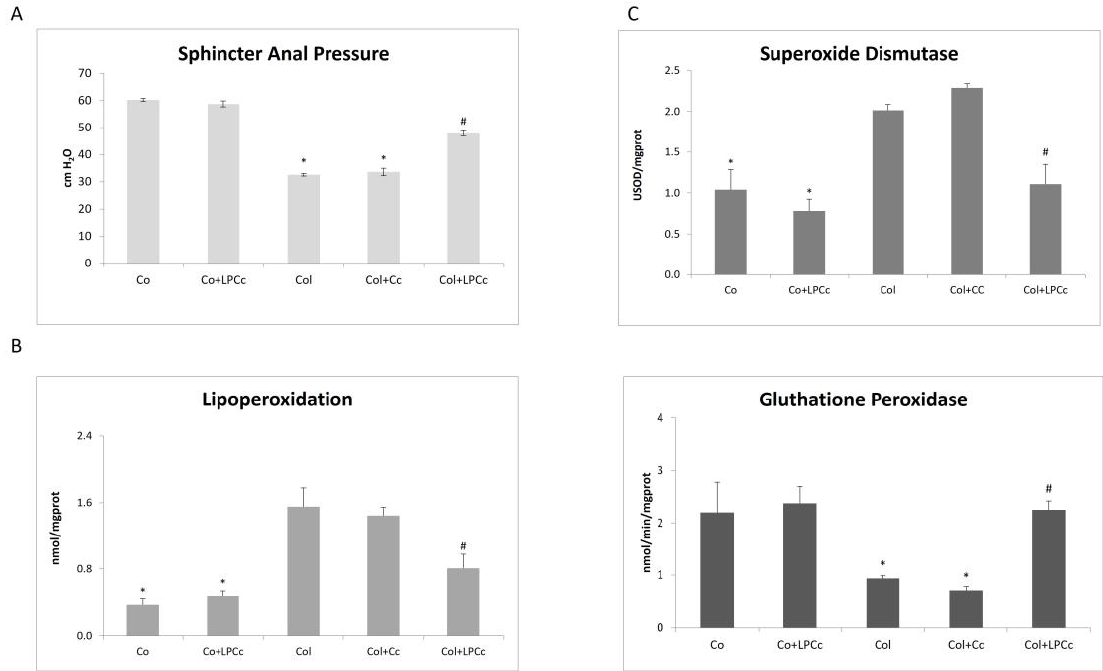
Figure 3. Effect of administration of LPC cookies on rat with acetic acid-induced colitis. Anal sphincter pressure ( A ) and lipid peroxidation ( B ) were analyzed in both controls and diseased rats, as well as the activity of ROS-related enzymes superoxide dismutase ( C ) and glutathione peroxidase ( D ). Values are expressed as the mean ± standard error. Co: control; Co+LPCc: control + LPC cookie; Col: colitis; Col + Cc: colitis + control cookie; Col + LPCc: colitis + LPC cookie. * represents p < 0.001 when compared to the control and # p < 0.001 when compared to